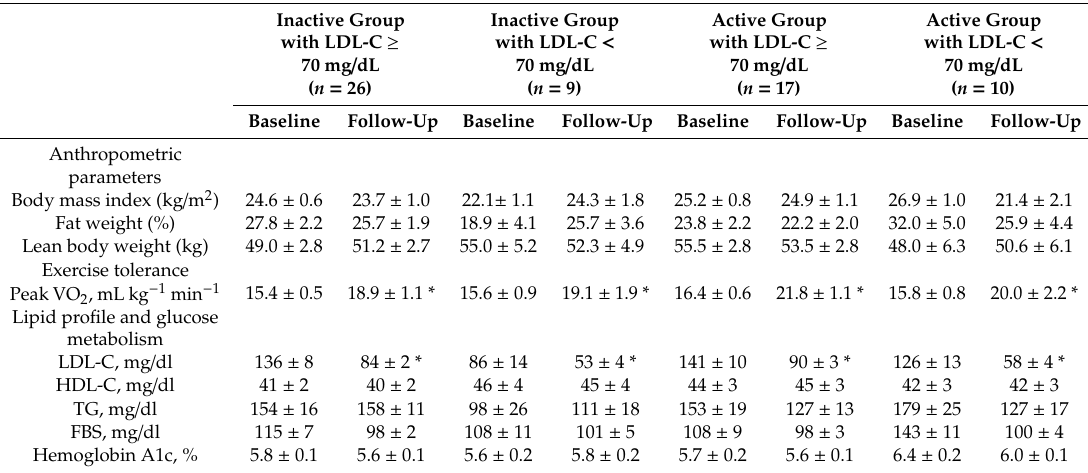
Table 2. Comparison of anthropometric parameters, lipid profile and exercise tolerance among the four groups at baseline and